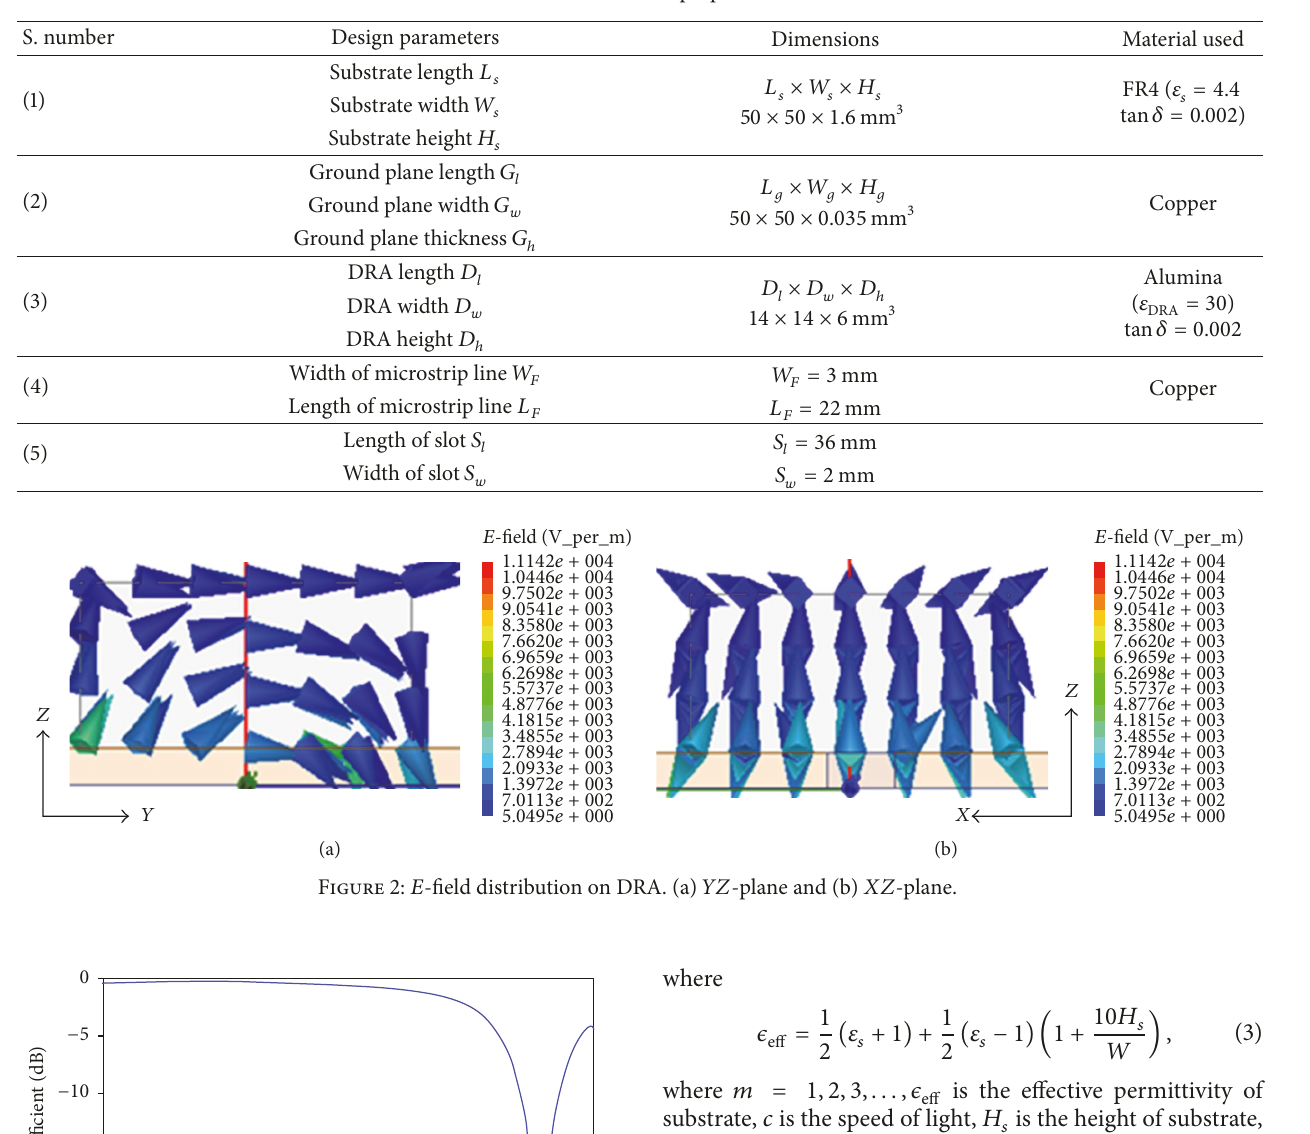
Table 1: Dimensions of the proposed FR DRA.